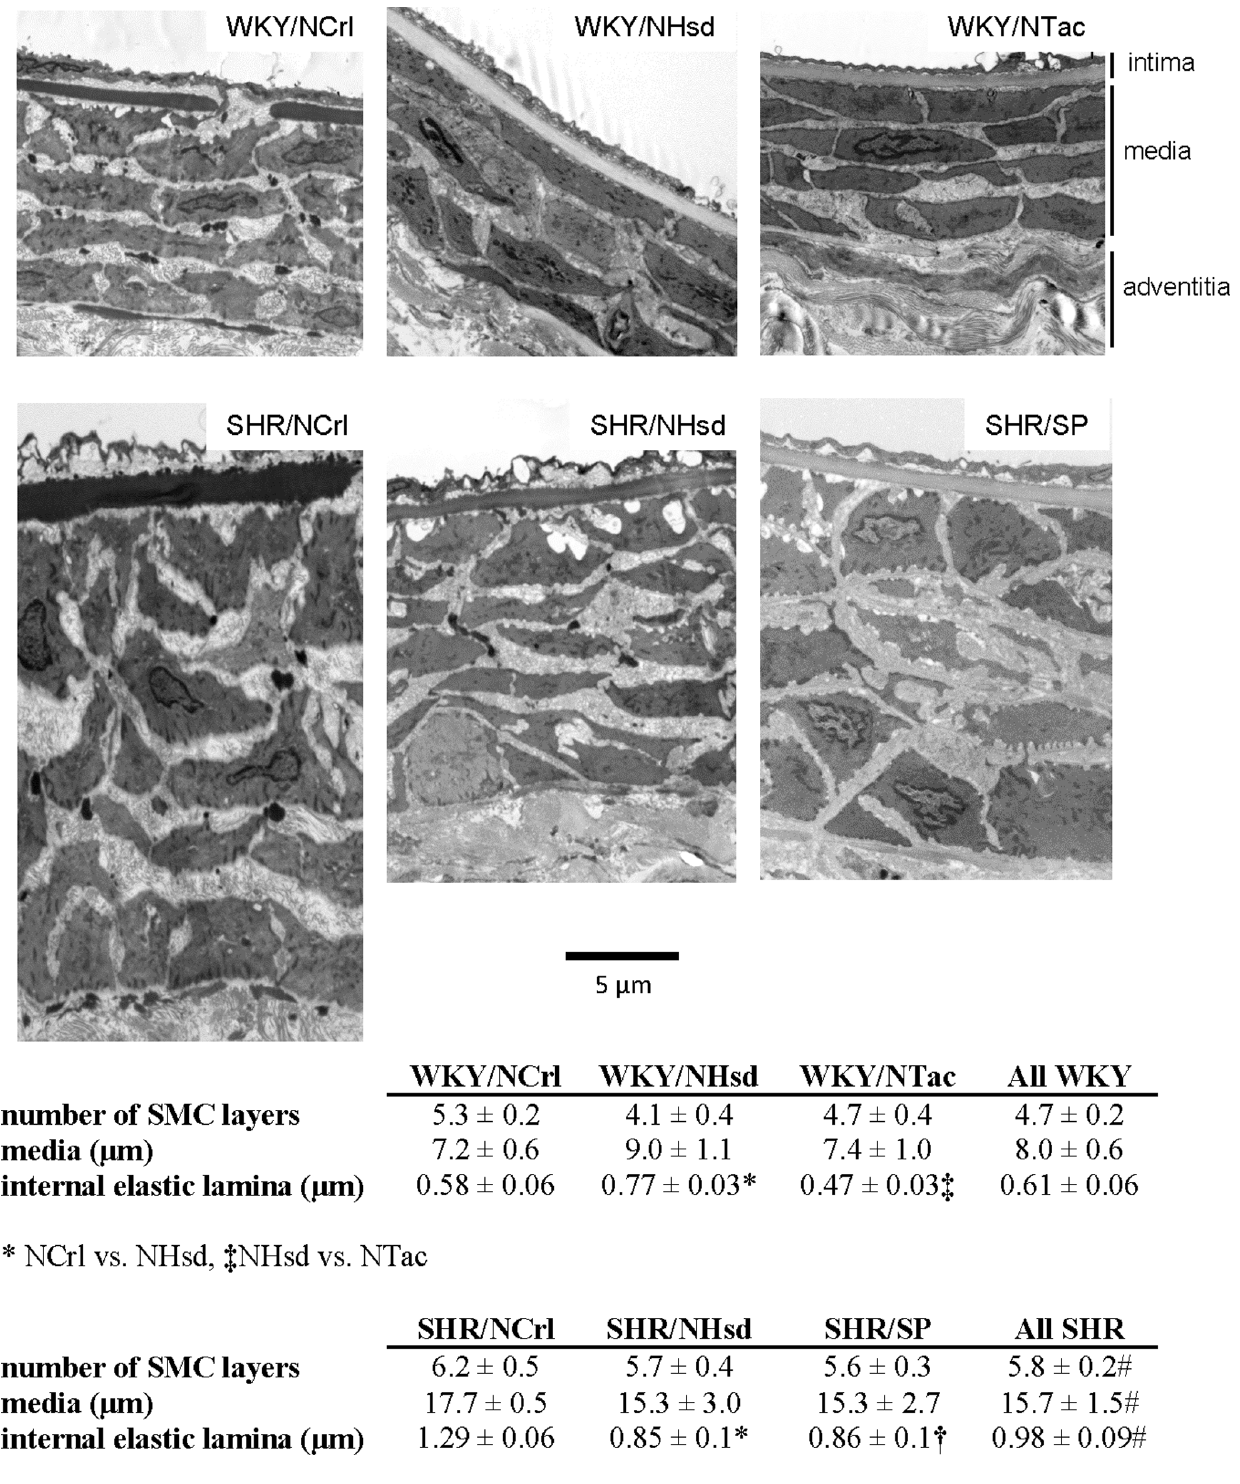
Figure 5. Vessel ultrastructure. Panel A depicts examples of mesenteric arteries from 5 months old rats from all groups. Panel B shows the quantification of parameters derived from EM images. From each group, 3 vessels were analyzed. SHR vessels show an increase in the number of smooth muscle cell (SMC) layers, a thicker media and a thicker internal elastic lamina. doi:10.1371/journal.pone.0107998.g005 both cardiac and vascular remodeling are time-dependent [24,25]. Thus, differences in the dynamics of remodeling may be present among sublines of rats.